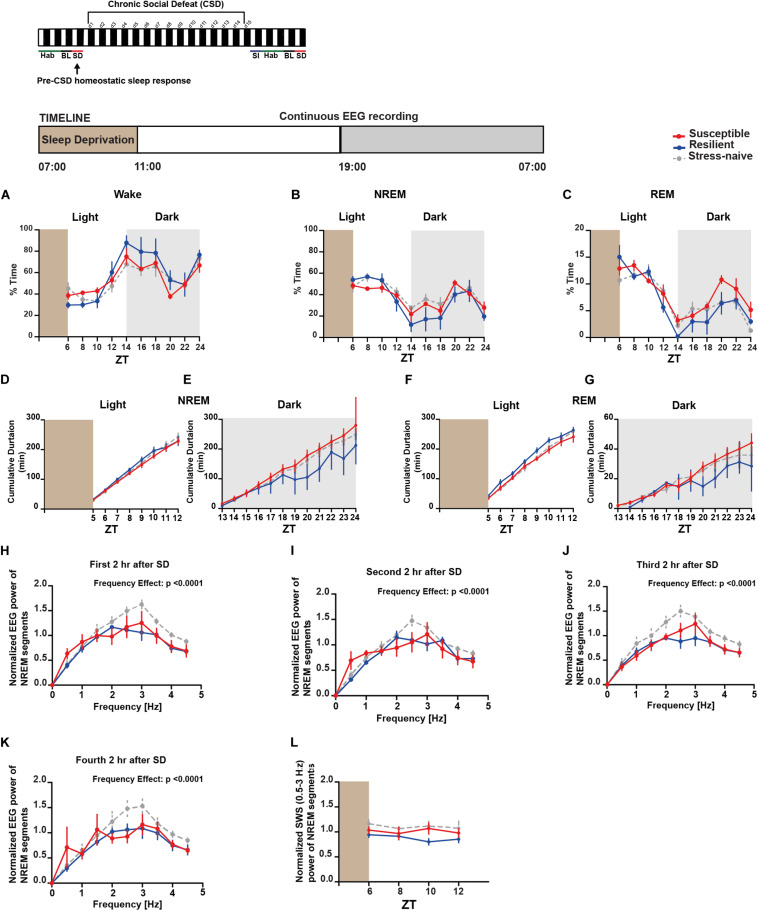
Pre-CSD stress: homeostatic sleep response was comparable between the three phenotypes. (A–C) There was no difference in the time spent in the different vigilance states among the three phenotypes post SD. (D) Resilient mice spent more time in NREM as the time progressed during the light (p < 0.05), and (E) displayed lower average cumulative duration of NREM during the dark as they spent more time awake (p < 0.05) relative to susceptible mice. (F) Additionally, resilient mice exhibited greater average cumulative duration of REM during the light relative to stress-naïve and susceptible mice (p < 0.05 and p < 0.05, respectively), and (G) exhibited lower average cumulative duration of REM during the dark as they spent more time awake relative to susceptible (p < 0.05). (H–K) Power spectral analysis of EEG recordings of NREM state 2, 4, 6, and 8-h after SD. Power spectra are normalized to the pre-stress baseline average value of SWA (0.5–4.5 Hz) during the 12-h light phase. (L) The low frequency range of normalized SWA (0.5–3 Hz) of NREM bouts, following 4-h SD, was quantified and averaged across 2-h time intervals. There was no difference in normalized SWA (0.5–3 Hz) of NREM bouts between the 3 phenotypes following SD. Values are expressed as percentage of total recording time (A–C) or normalized power (H–L) (mean ± sem). n = 4–6 for each group.